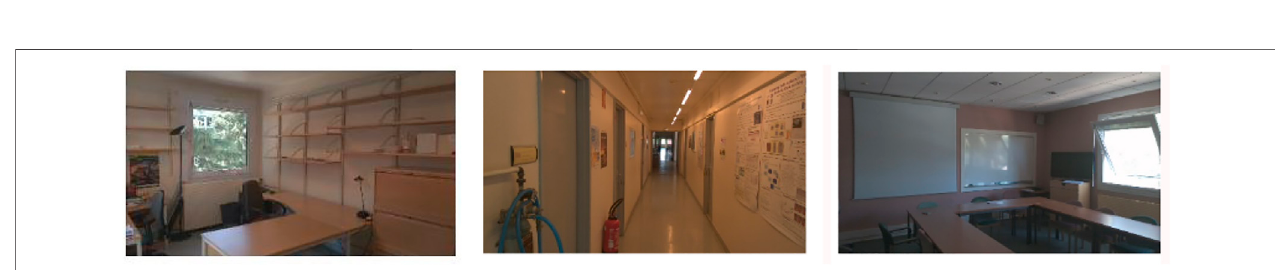
FIGURE 11 | Images of the rooms used for